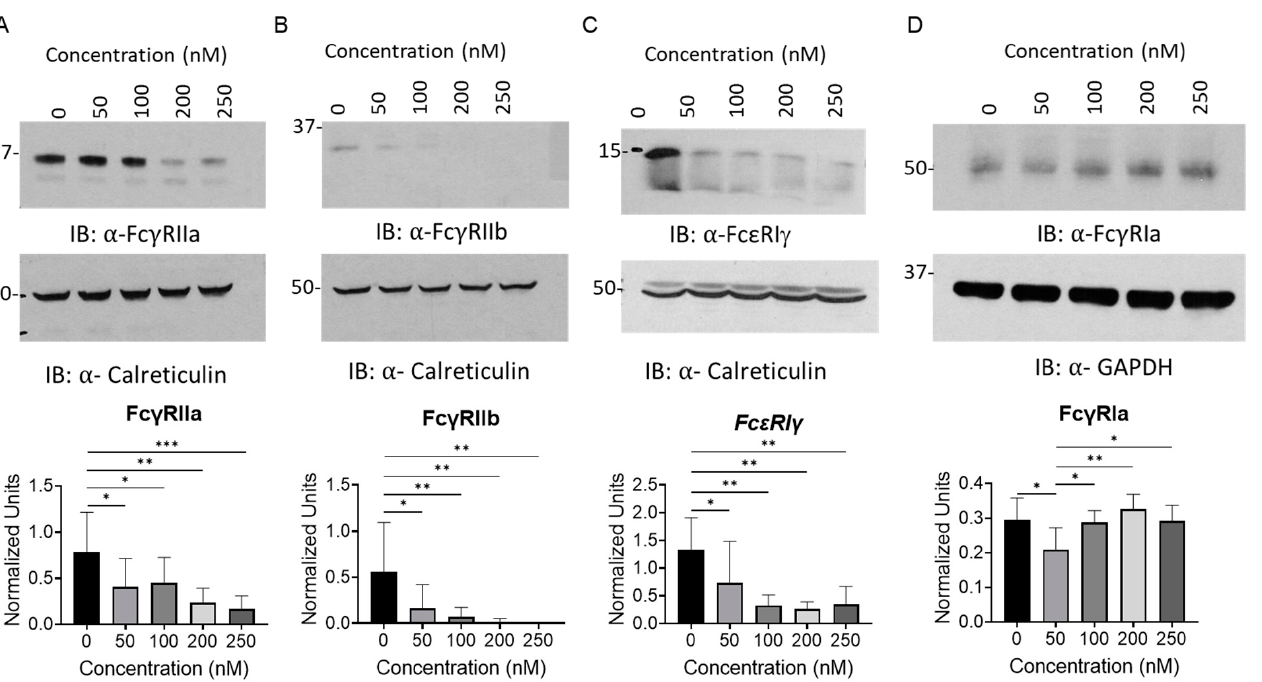
Figure 1. BET inhibition reduces Fc γ R transcript in human monocytes. Healthy donor CD14+ monocytes were cultured for 24 h with PLX51107 (50, 100, 200, 250 nM) or with vehicle control (DMSO). Transcript expression was analyzed by real-time PCR for ( A ) Fc γ RIIa, ( B ) Fc γ RIIb, ( C ) Fc γ RIIIa, ( D ) Fc ε RI γ , and ( E ) Fc γ RIa. (n = 8). * p ≤ 0.05, ** p ≤ 0.01, **** p ≤ 0.0001 respectively.